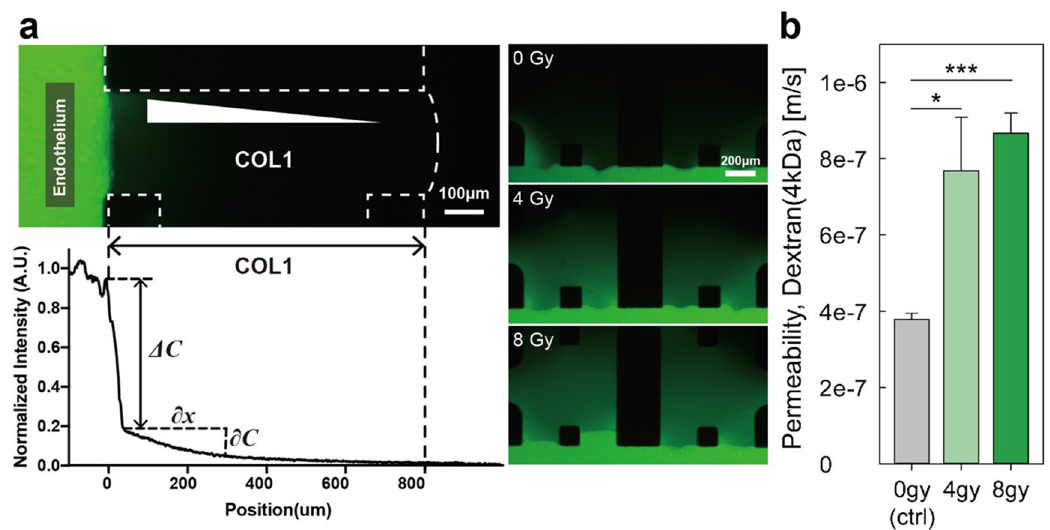
Figure 4. Representative fluorescence images and calculated permeability values of endothelial barriers after irradiation. ( a ) The tight hMVECs’ monolayer showed a sharp decrease in the intensity ( (cid:31) C ) at the interface between the hMVECs and the remodeled ECM. In addition, the intensity gradient (cid:31) measured in the normalized intensity profile with ImageJ (1.52q, NIH, www. imagej. nih. gov/ ij). These intensity values vary according to the barrier permeability. (b) The permeability values of the hMVECs’ monolayer